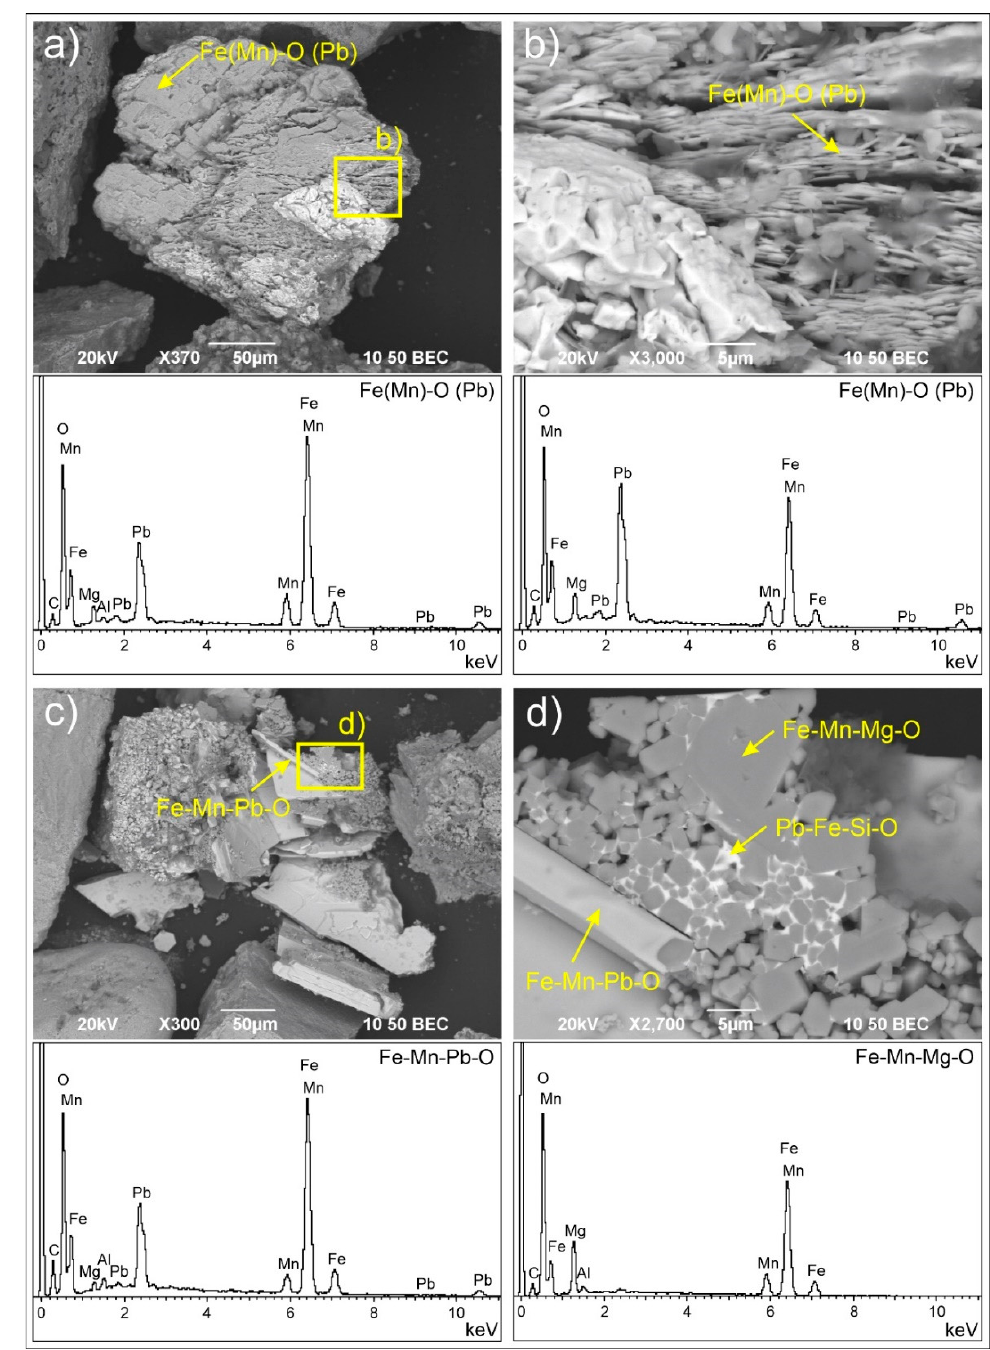
Figure 5. SEM(BSE) images and EDS spectra of solid Fe carriers in stream sediment: ( a ) large Fe(Mn)- O particle with high Pb content and embedded cerussite; ( b ) detail showing laminated hexagonal crystals of Fe(Mn)-oxides/oxyhydroxides with high Pb content; ( c ) large platy, angular Fe-Mn-Pb- oxide crystals, and ( d ) Fe-Mn-Mg-oxide with octahedral crystal habits, cemented by amorphous Pb-Fe-Si-O